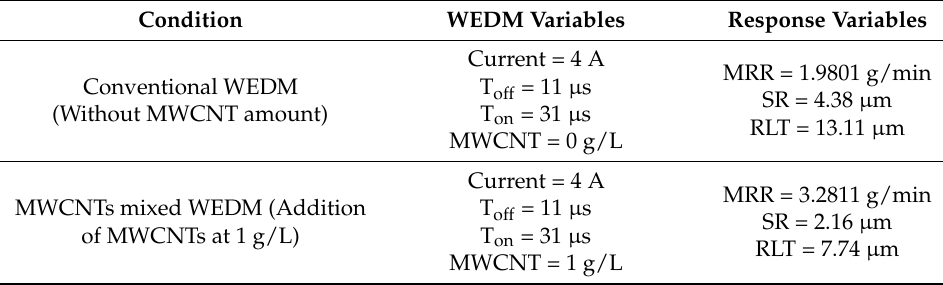
Table 8. Influence of MWCNT on MRR, SR, and RLT. Condition WEDM Variables Response